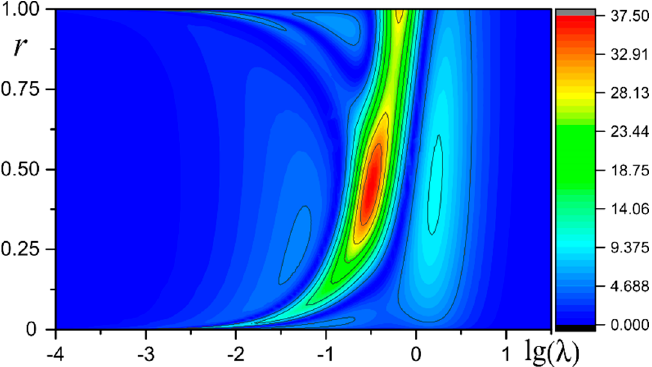
Figure 9. The relative error Δ p ( r , λ ) of the simplified distribution of the contact stresses for β = 0.1 in %.